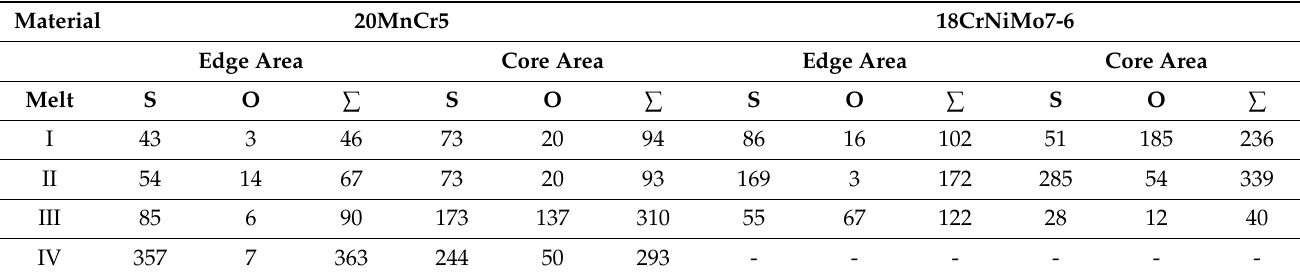
Table 1. Degree of purity K1 according to DIN 50602 (method